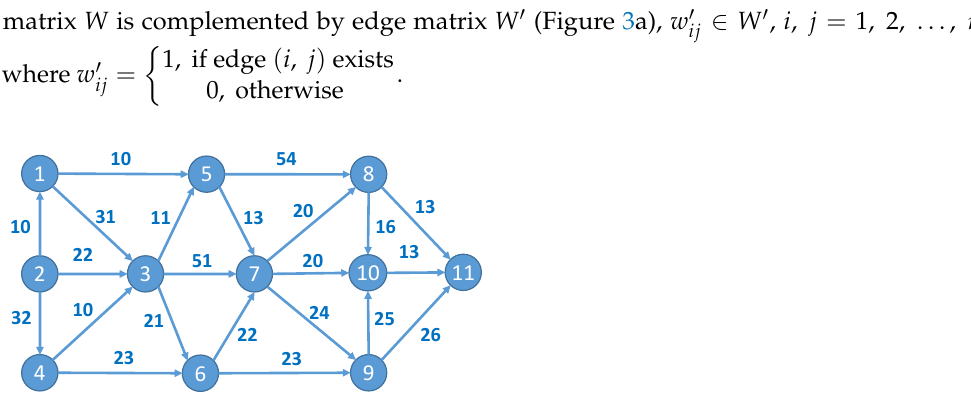
Figure 2. A sample graph representing the fog network.